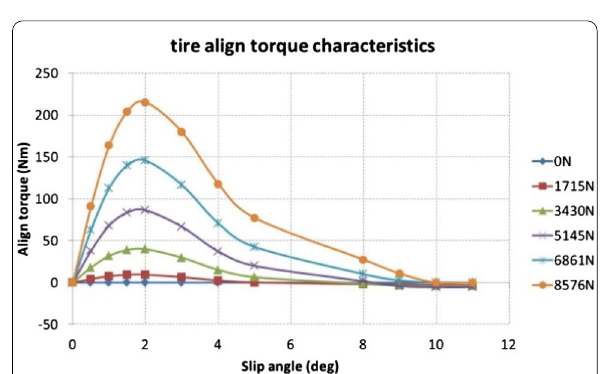
Figure 3 Tire align torque